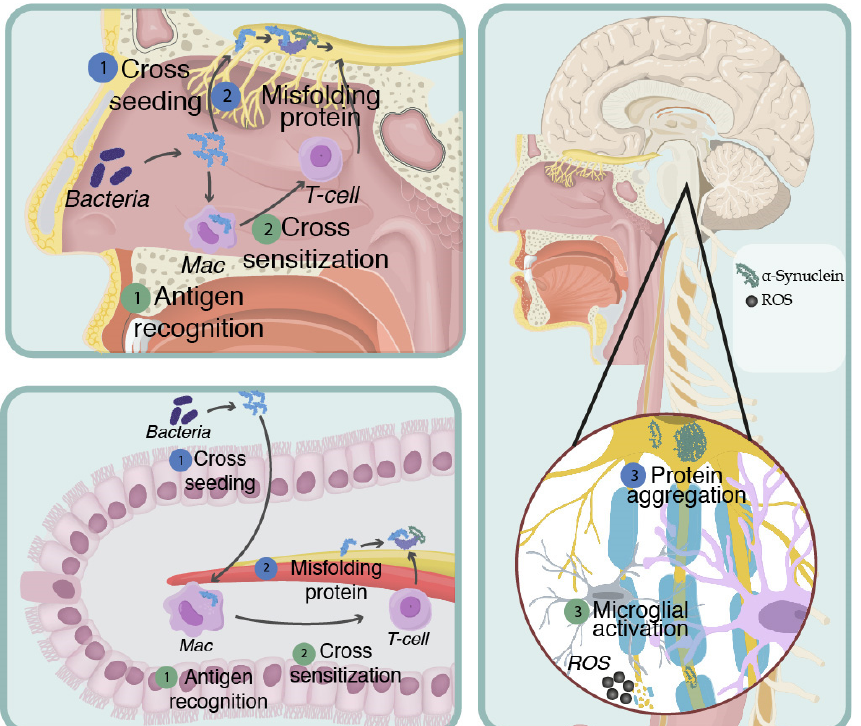
Figure 2. Mapranosis. Schematic representation of Friedland and Trudler’s proposal to explain neurodegeneration. Amyloid is secreted by bacteria resident in the nasal and intestinal epithelium, which causes neuroinflammation in two ways: 1. Misfolded Protein 1.1. Bacterial amyloid can cross seed with host beta-amyloid and alpha-synuclein. 1.2. This cross seeding induces the wrong folding of the alpha-synuclein due to prionic behavior; therefore, it extends through the vagus and olfactory nerve. 1.3. The new poorly folded endogenous proteins it disseminates reaches the CNS, causing neuronal death. 2. Induction of oxidative stress and neuroinflammation. 2.1. Bacterial amyloid is capable of inducing inflammation and oxidative stress. 2.2. Subsequently, there is cross sensitization against endogenous amyloid, which causes the immune system’s abnormal recognition of its epitopes, mounting a response directed against beta-amyloid and alpha-synuclein in the host’s CNS. 2.3. The sensitized immune cells reach the CNS through the hematogenous pathway, crossing the BBB, and activating the microglia, causing neuronal